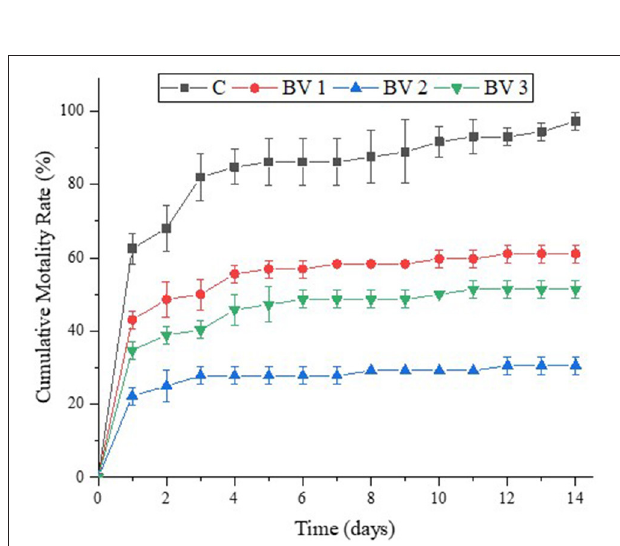
FIGURE 6 | Effects of dietary administration of B. velezensis on the cumulative mortality percentage of L. vannamei after infection with V. parahaemolyticus .